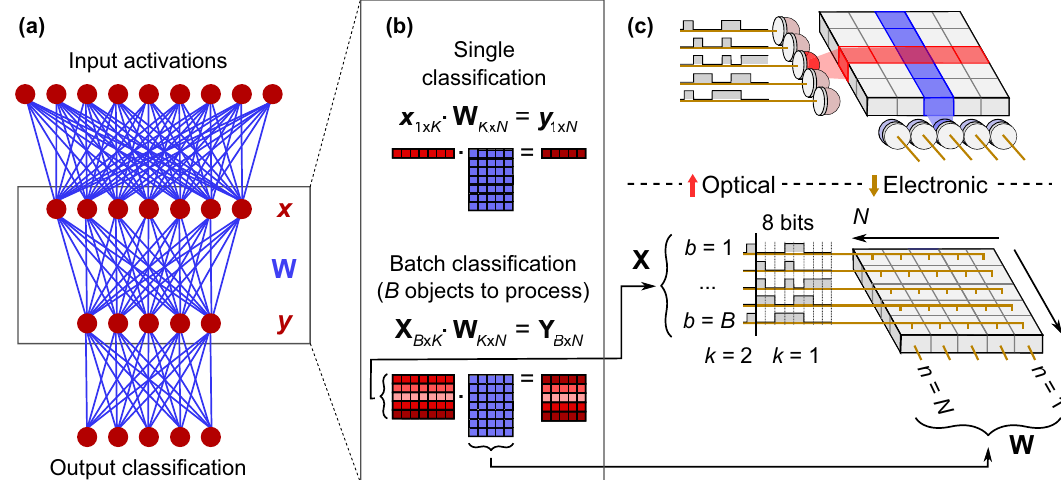
Figure 2. Digital fully-connected neural network (FC-NN) and hardware implementations. ( a ) FC-NN with input activations (red, vector length K ) connected to output activations (vector length N ) via weighted paths, i.e., weights (blue, matrix size K × N ). ( b ) Matrix representation of one layer of an FC-NN with B -sized batching. ( c ) Example bit-serial multiplier array, with output-stationary accumulation across k . Fan-out of X across n ∈ { 1 . . . N } ; fan-out of W across b ∈ { 1 . . . B } . Bottom panel: all-electronic version with fan-out by copper wire (for clarity, fan-out of W not illustrated). Top panel: digital optical neural network version, where X and W are fanned out passively using optics, and transmitted to an array of photodetectors. Each pixel contains two photodetectors, where the activations and weights can be separated by, e.g., polarization or wavelength filters. Each photodetector pair is directly connected to a multiplier in close